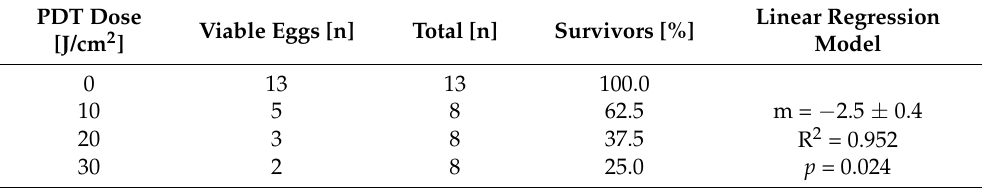
Table 2. Determination of suitable PDT dose in the CAM assay. Three different doses of red light (635 nm) at a fixed intensity (26 mW/cm 2 ) were tested on embryos at EDD15 without xenografts. Following 24 h exposure, the viable embryos were counted and survivor percentage was calculated. To test for correlation between PDT dose and survivor percentage, the shown data was used to perform a linear regression analysis.